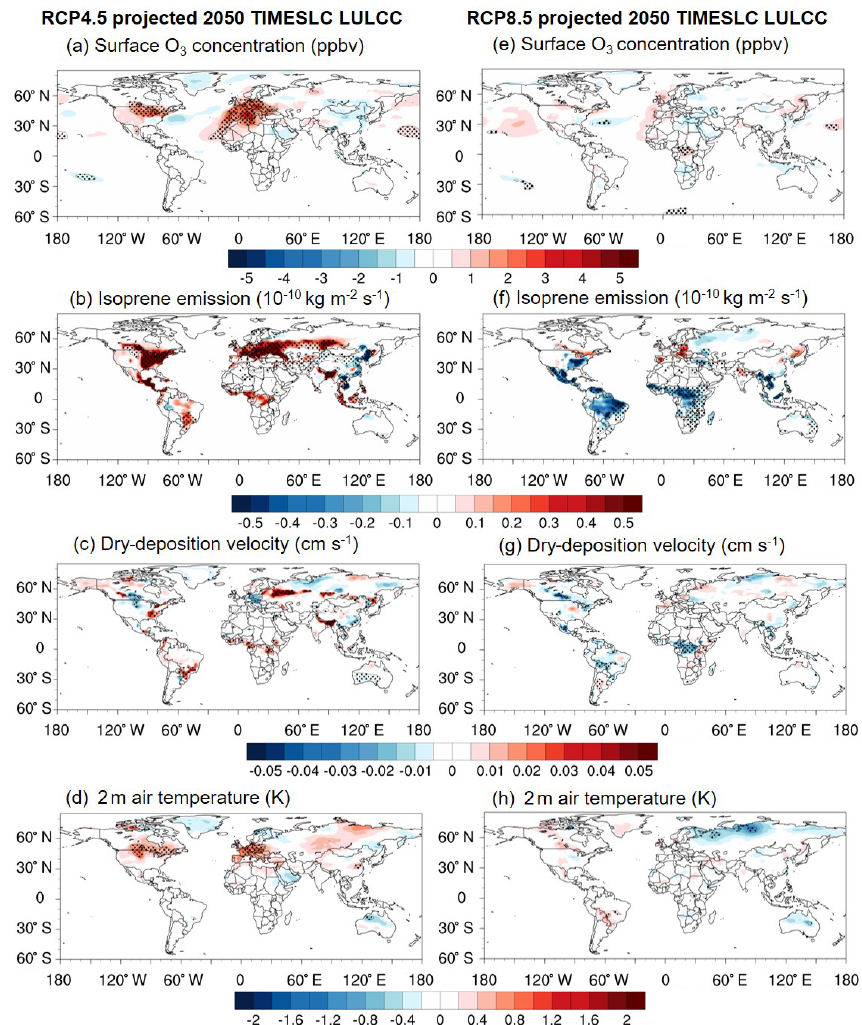
Figure 4. Simulated 2000-to-2050 changes in surface ozone, isoprene emission, dry-deposition velocity, and 2m air temperature for the boreal summer averaged over the 30-year analysis window, under two future scenarios (RCP4.5 and RCP8.5) of LULCC. Regions with dots indicate changes that are significant at the 95% confidence level. These results are from the On-line runs (land forcing 2050 minus 2000) with dynamic meteorological responses to LULCC from time-sliced simulations On-line_45TS and On-line_85TS (Table